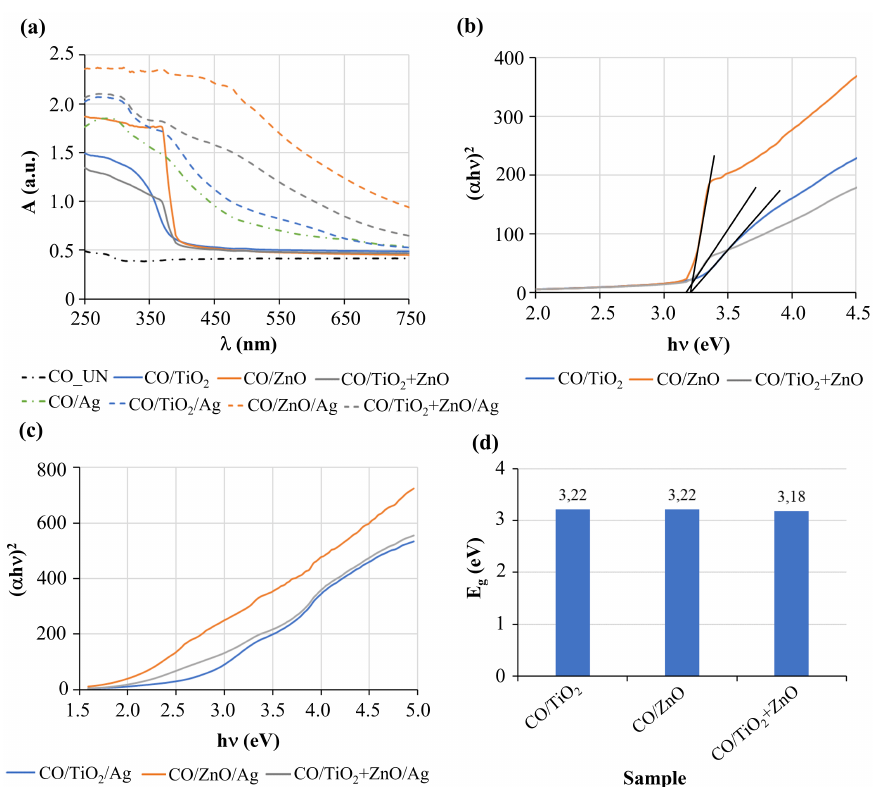
Figure 5. Absorption spectra of the untreated and chemically modified cotton samples ( a ); Tauc plots of the CO/TiO 2 , CO/ZnO and CO/TiO 2 + ZnO samples ( b ); Tauc plots of the CO/TiO 2 /Ag, CO/ZnO/Ag and CO/TiO 2 + ZnO/Ag samples ( c ); E g values of chemically modified cotton samples determined from Tauc plots ( d